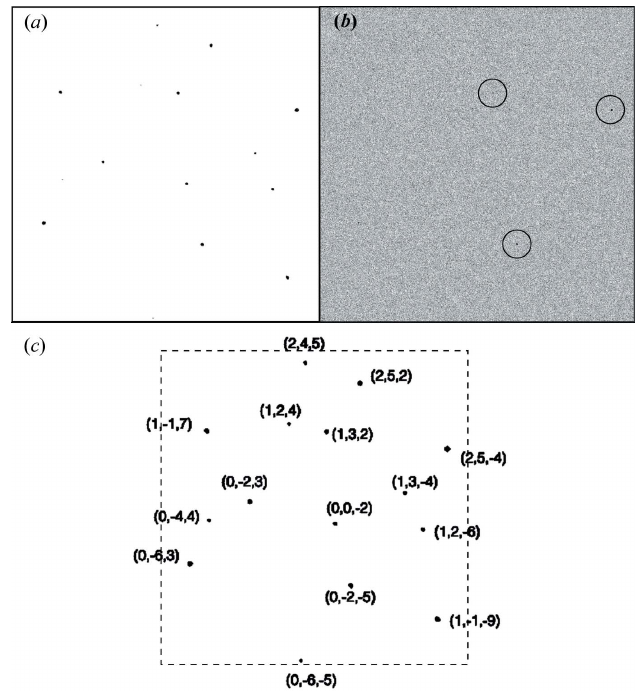
Figure 3 Simulated I3C patterns indexed by SPIND . ( a ) Simulated sparse diffraction pattern from an I3C crystal in the orientation specified by Euler angles (cid:3) 10.4676, 46.9022, 139.1443. ( b ) Poisson noise and random background noise added to ( a ), so only three Bragg peaks were identifiable (circled). ( c ) The indexing result by SPIND using only the three peaks in ( b ). The determined crystal orientation is at Euler angles of (cid:3) 10.5713, 46.8855, 139.2000. The peaks were predicted from the determined orientation and Miller indices were given for Bragg